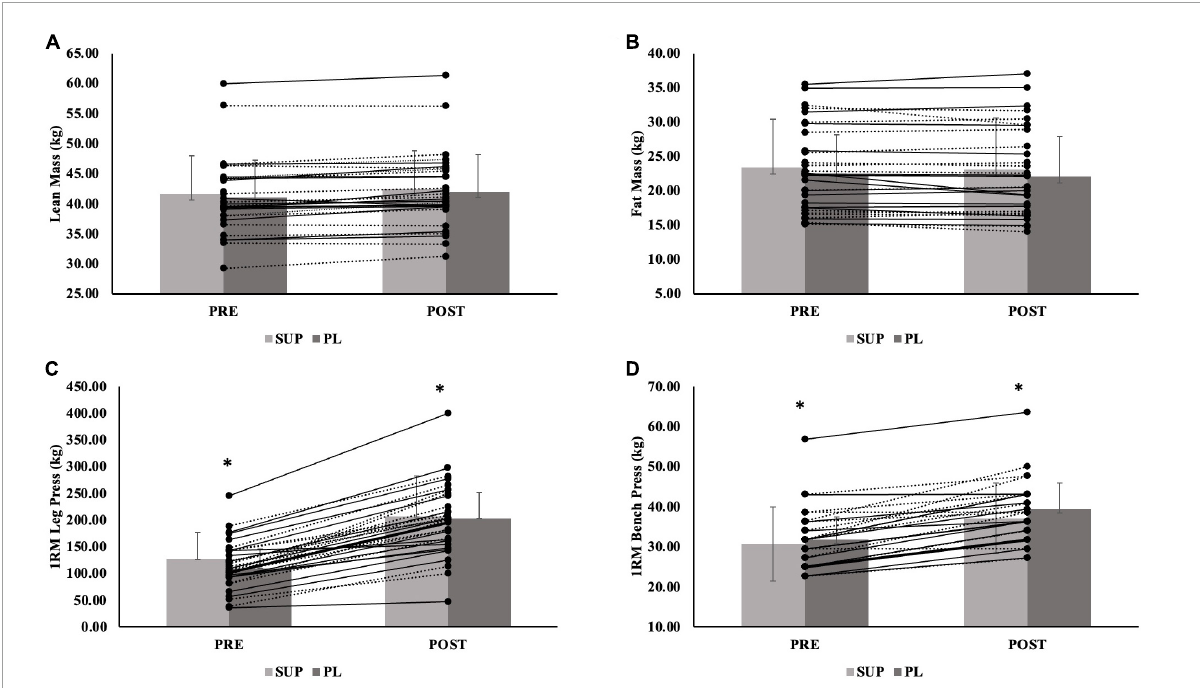
FIGURE4 (A–D) Female individual responses for (A) lean mass, (B) fat mass, and (C) 1RM leg press, and (D) 1RM Bench Press. The lines represent the differences between baseline (PRE) and post-testing visit (POST) per participant. The gray bars represent treatment mean with average standard deviation. The solid lines represent females in the supplement group ( n = 15). The dashed lines represent females in the placebo group ( n = 16). The gray bars represent treatment means for the supplement (SUP; light gray) and placebo (PL; dark gray) groups with average standard deviation (error bars). ∗ Indicates significant main effect for group for 1RM leg press ( p = 0.004) and 1RM bench press ( p =